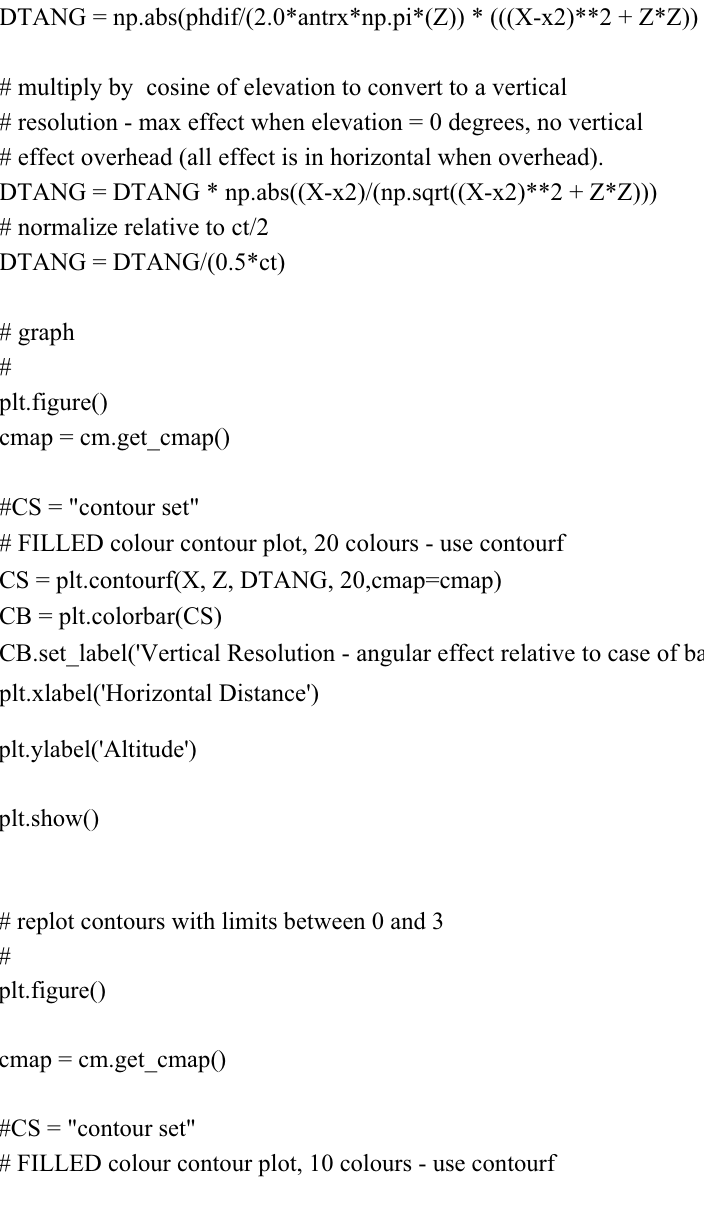
CS.cmap.set_over('brown')